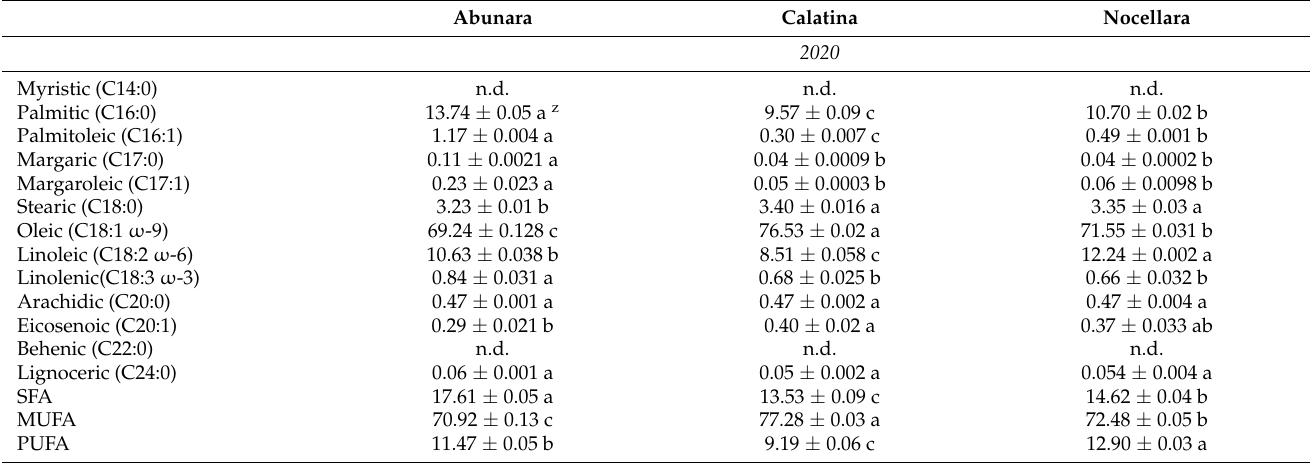
Table 3. Fatty acid composition (%) of virgin olive oils from ‘Abunara’, ‘Calatina’, and ‘Nocellara del Belice’ olive trees grown as central leaders at 2 × 5 m (CLx2), free palmette at 3 × 5 m (FPx3), globe vase at 4 × 5 m (GVx4), and polyconic vase at 5 × 5 m (PVx5) in the last two years of trials. Data are expressed as means ± standard deviation (n = 12). For each cultivar, data from different planting systems were pooled